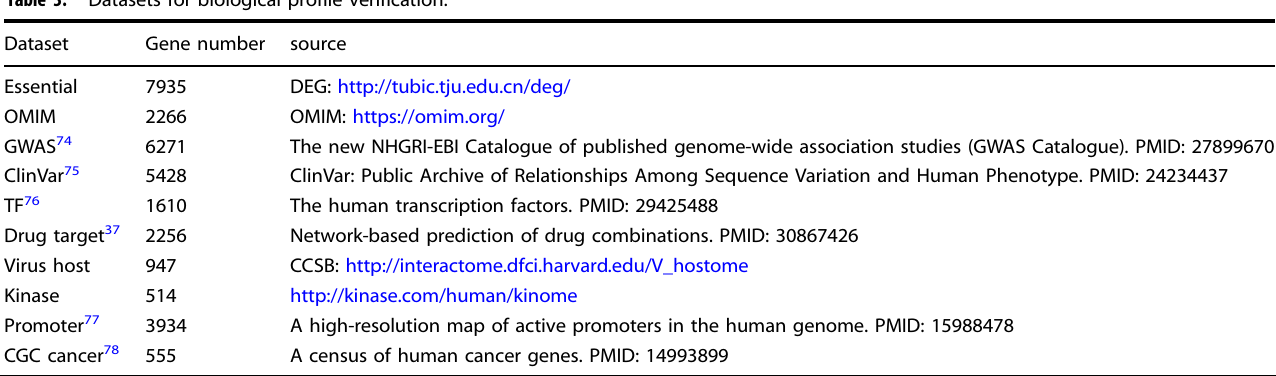
Table 3. Datasets for biological pro fi le veri fi